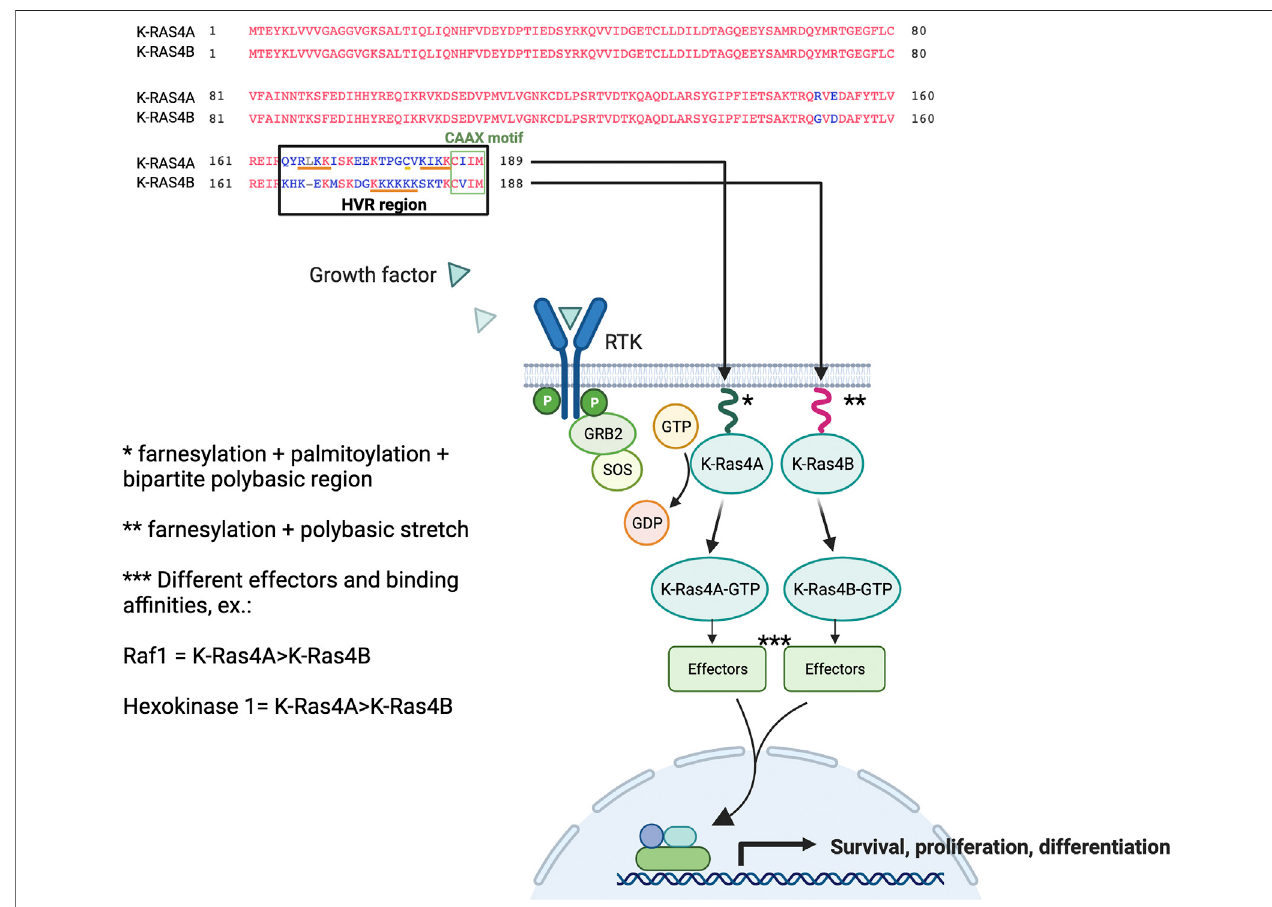
FIGURE 2 | K-RAS4A versus K-RAS4B protein sequence and signalling. RAS proteins contain a G domain (residues 1 – 165) responsible for the catalytic and switching portion of the protein that interacts with GDP/GTP, exchange factors, and GTPase-activating proteins (GAPs). The less homologous part corresponds to the hypervariable region (HVR) domains ( fi nal 23/24 residues). RAS are farnesylated on their C-terminal cysteine residue (CAAX motif), undergo AAX proteolysis and receive carboxyl methylation at the C-terminal prenylcysteine to allow the fi rst step in membrane binding. A second motif improves this weak binding, which is a hexa-lysine polybasic stretch (residues 175 – 180) that interacts electrostatically with membranes in the case of K-RAS4B. Whereas, K-RAS4A membrane binding is stabilised by a monopalmitoylation site (residue 180), whereas this site is absent in the isoform K-RAS4B (Hancock et al., 1991). The KIKK motif (residues 182 – 185) was shown to be an additional membrane-targeting motif for K-RAS4A (Zhao et al., 2015), in addition to other basic motif corresponding to RLKK (residues 167 – 170) (Tsai et al., 2015). The binding of growth factors tothe extracellular regions of receptor tyrosine kinases(RTKs) initiates the signal that will lead to the activation of RAS proteins downstream ofthe receptor. The isoforms can bind to a variety of effectors with variable af fi nities where, for example, hexokinase 1 was shown to bind to K-RAS4A with higher af fi nity than to K-RAS4B; the same was observed for Raf1 (Zhang et al., 2018; Amendola et al., 2019). Part of the fi gure was built and adapted from the “ Ras Pathway ” template, by